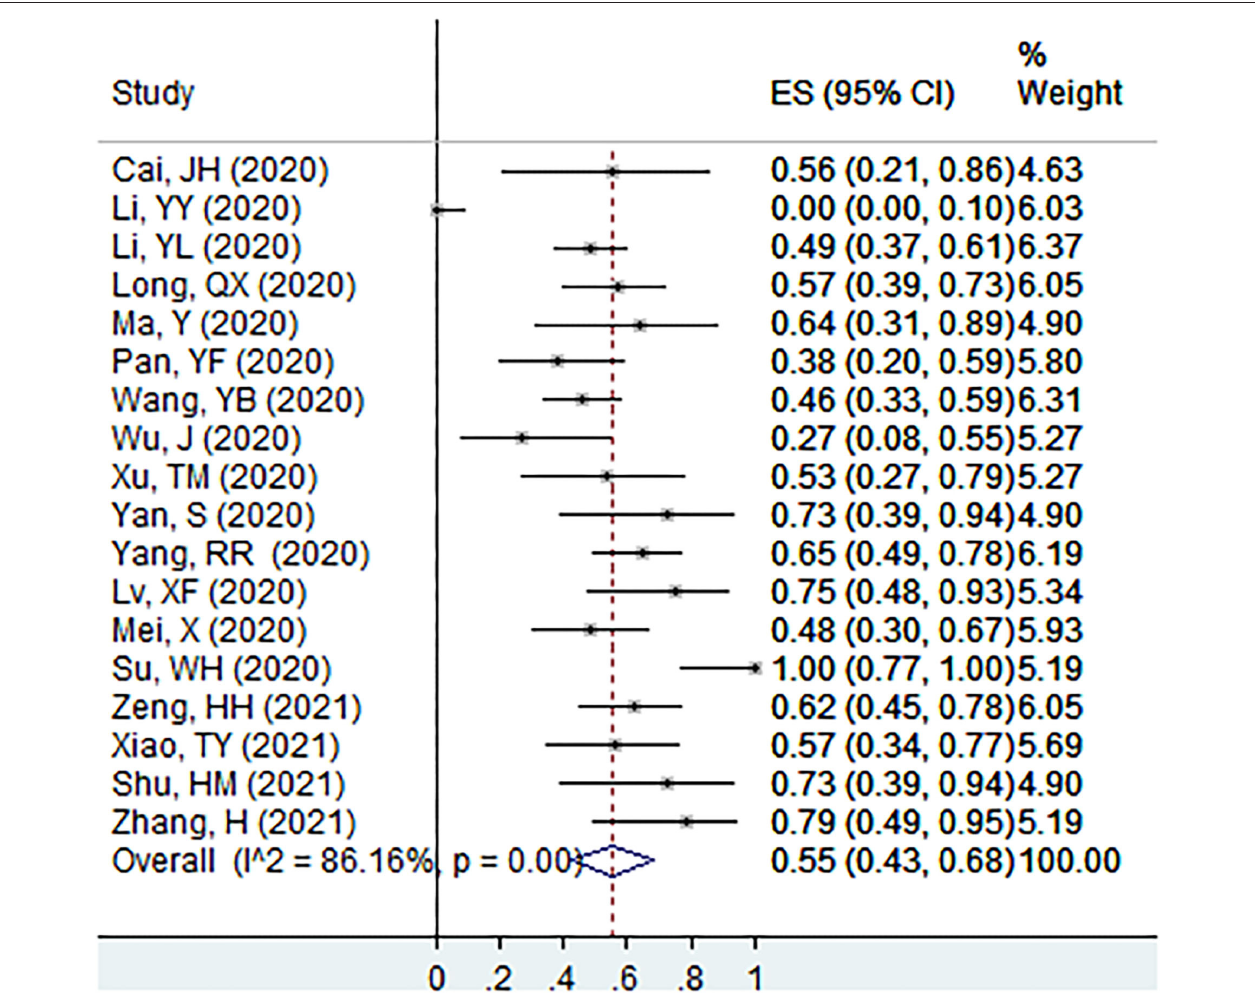
FIGURE 3 | The proportion of individuals with abnormal CT features in patients with asymptomatic infection at the screening point.